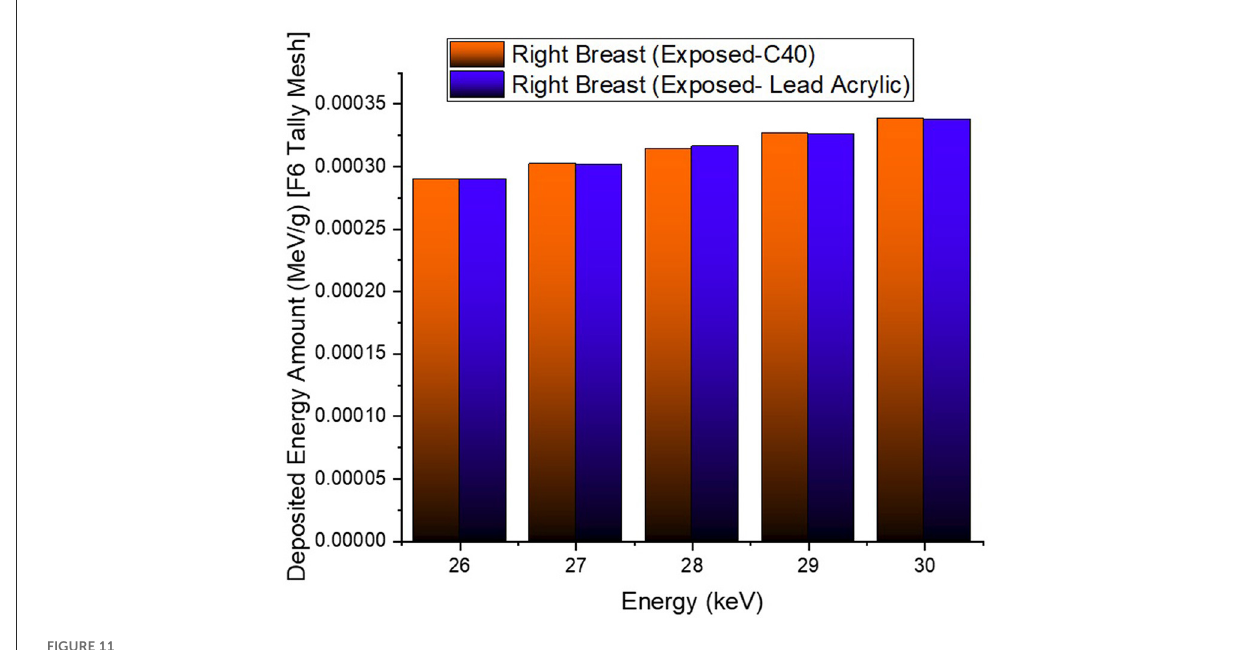
FIGURE11 Variation of total deposited energy amount in the right breast.